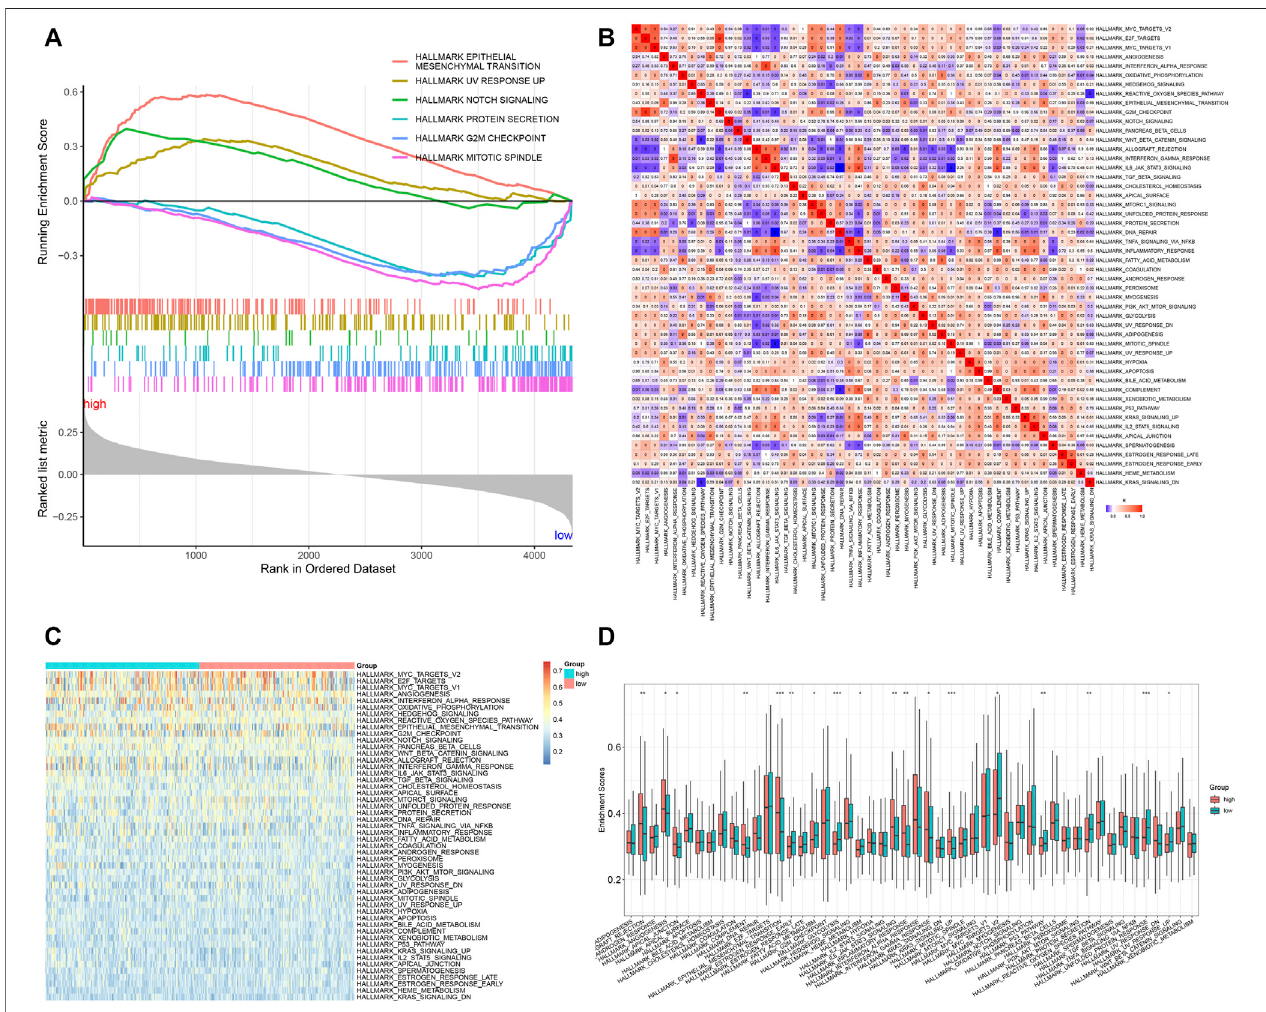
FIGURE 5 | Signal pathways involved in the TNF α -derived gene signature. (A) GSEA for the differential hallmark gene sets between high- and low-risk GC specimens. (B) Heatmap showing the interactions between hallmark gene sets across GC specimens. (C) Heatmap showing the activities of hallmark gene sets in two groups. (D) Comparison of the activities of hallmark gene sets between groups. * p < 0.05; ** p < 0.01; *** p <